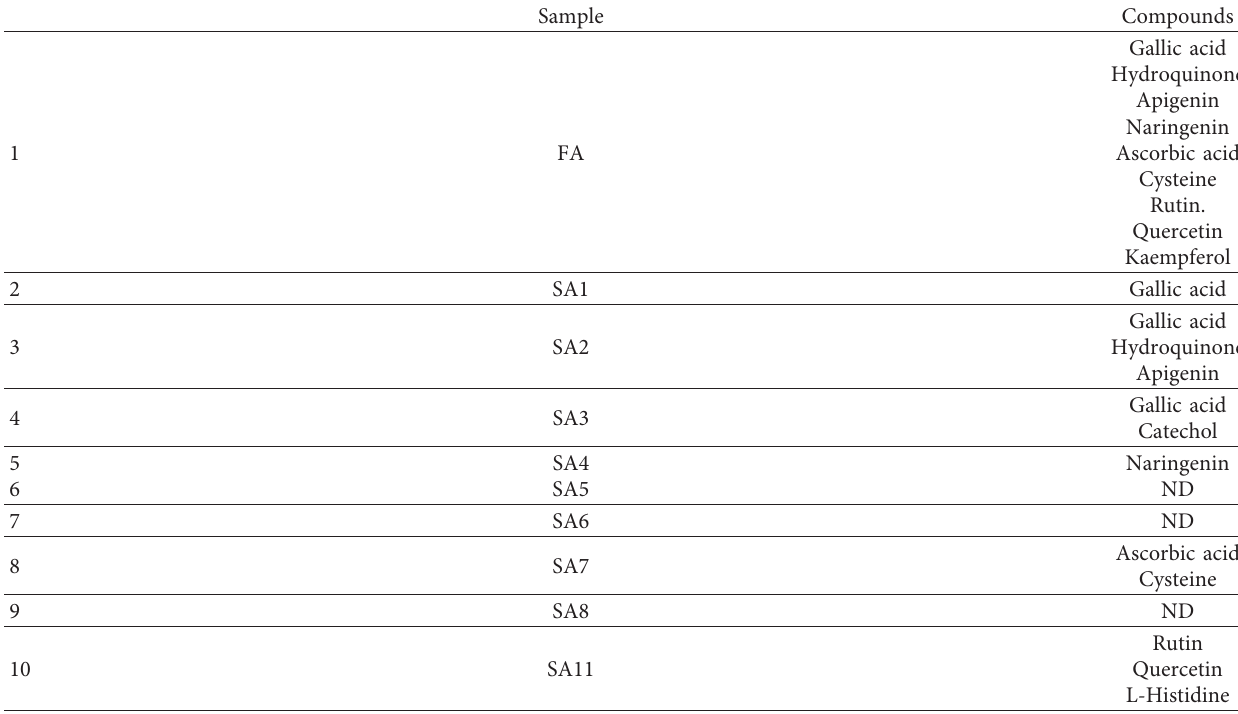
Table 4: Characterization by HPLC-DAD of fractions chemical compounds generated from the acetone mother extract FA .